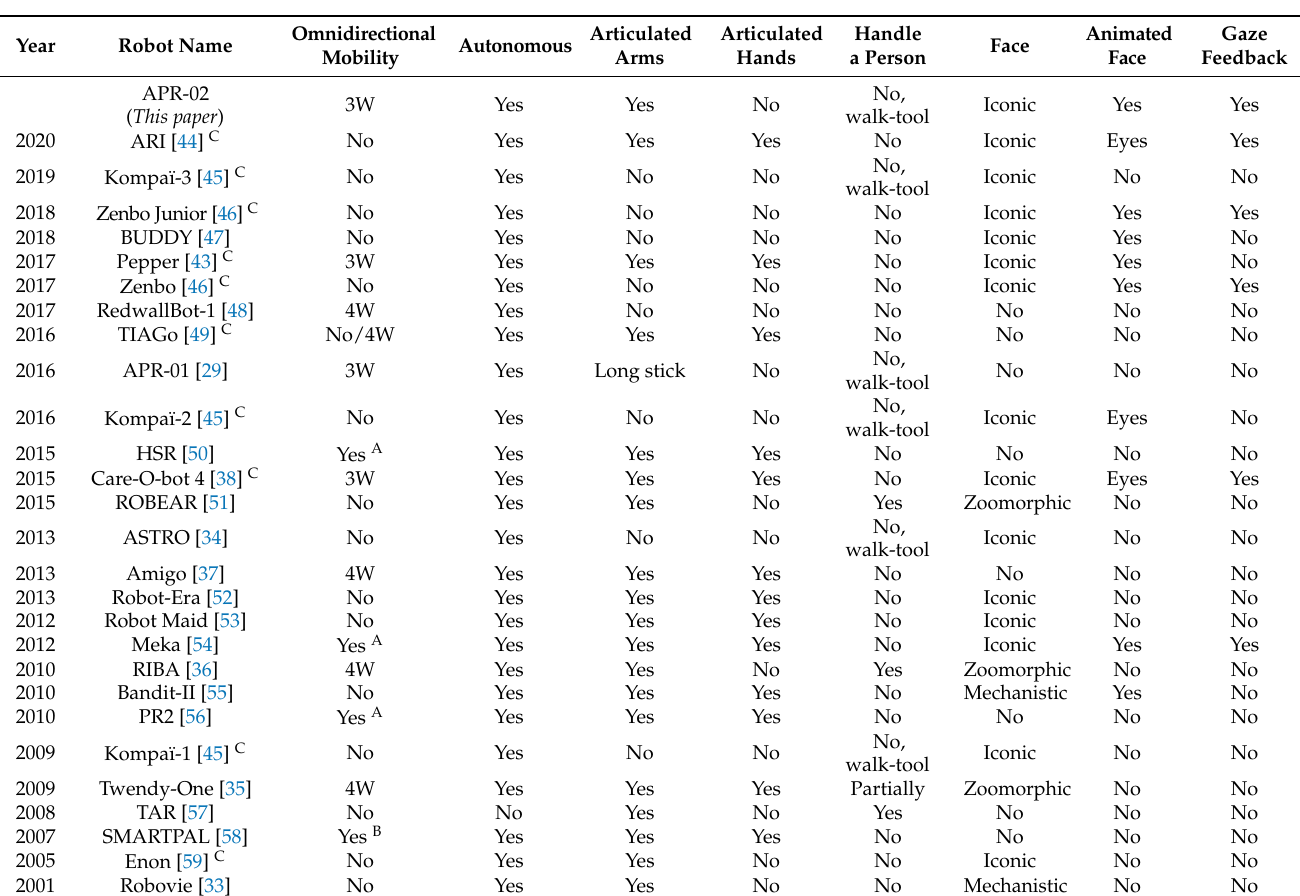
Table 1. List of wheeled assistant or companion mobile robots used as references during the evolution of the APR mobile